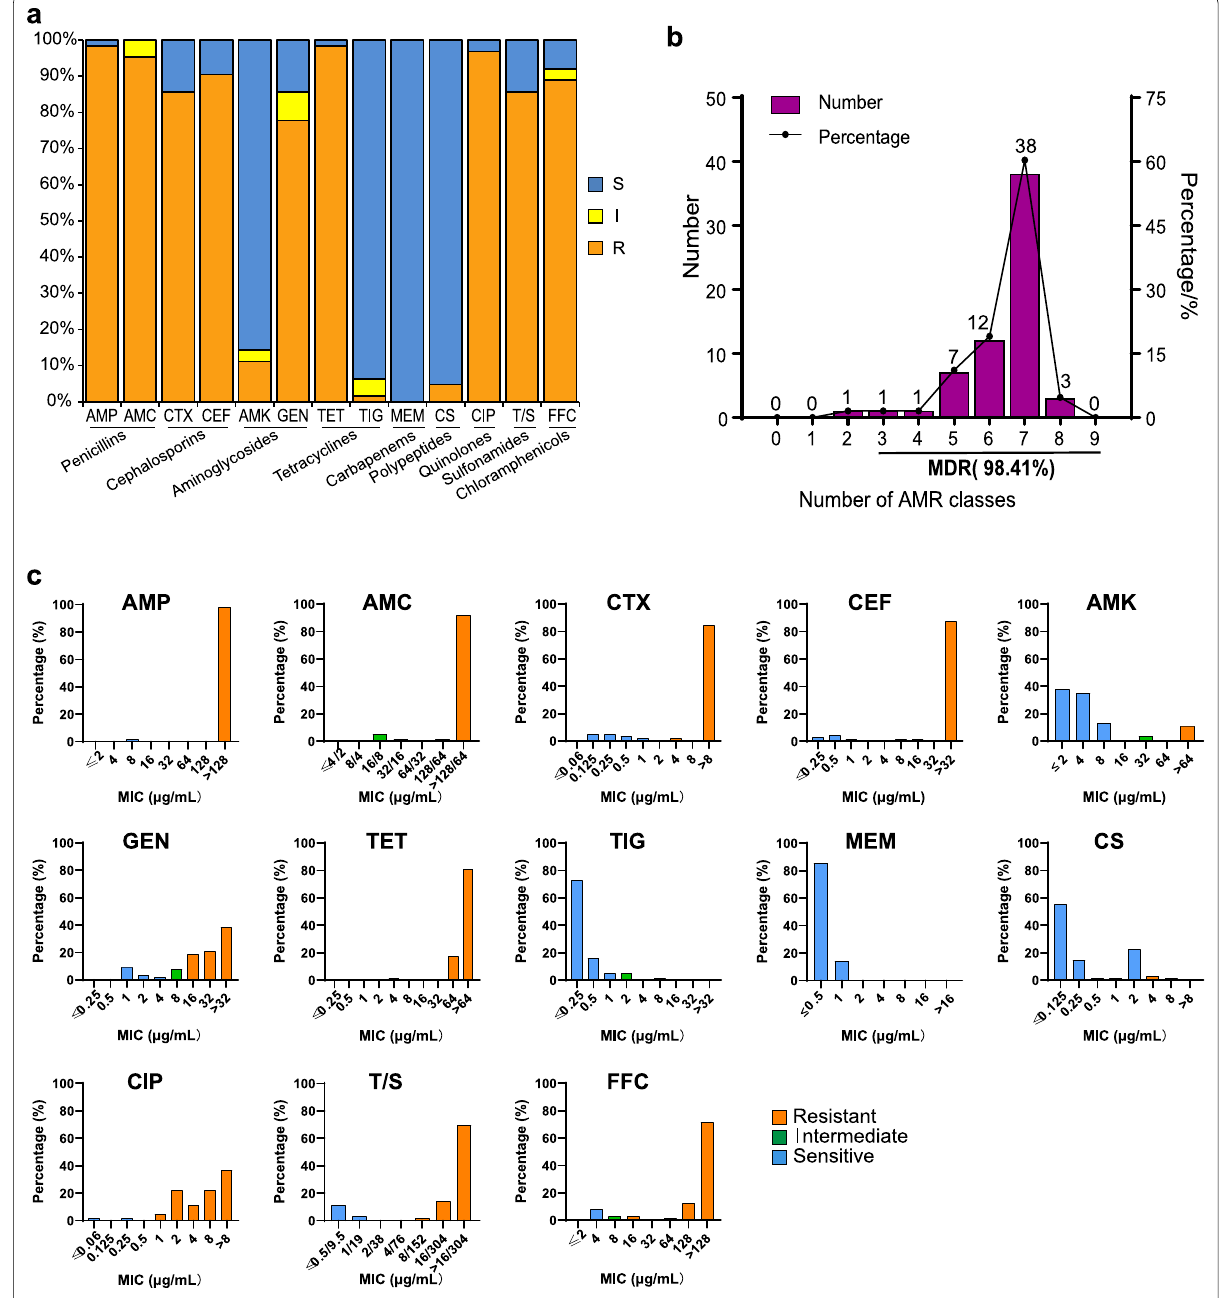
Fig. 1 The susceptibility test results of 63 strains of E. coli to 13 antibiotics. a AMR rates of Escherichia coli . b The distribution of multidrug-resistant strains. c MIC distributions of 13 antibiotics in isolated E. coli strains. MIC minimum inhibitory concentration, MDR multidrug resistance, AMP ampicillin, AMC amoxicillin/clavulanate potassium, CTX cefotaxime, CEF ceftiofur, AMK amikacin, GEN gentamicin, TET tetracycline, TIG tigecycline, MEM meropenem, CS colistin, CIP ciprofloxacin, T/S sulfamethoxazole, FFC